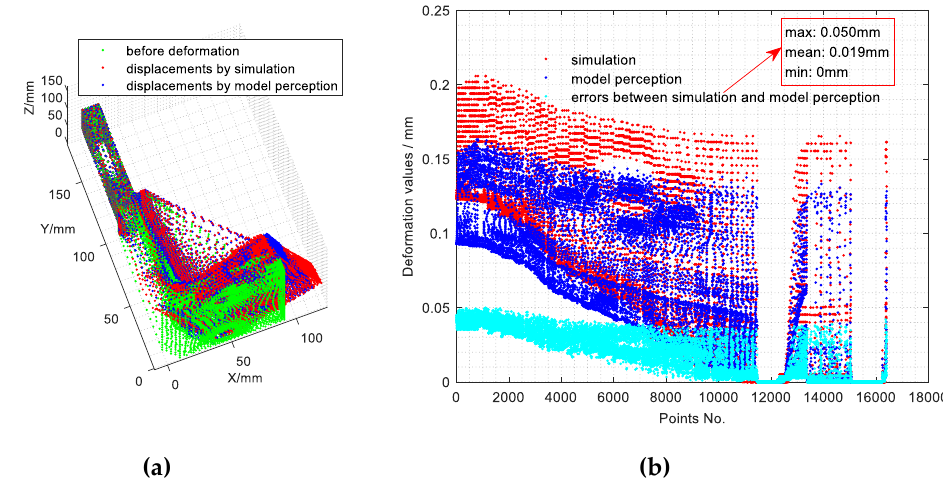
Figure 8. Comparison between the simulation and the model perception. ( a ) Full-field displacements based on simulation and model perception. ( b ) Absolute errors between the results of simulation and model perception.